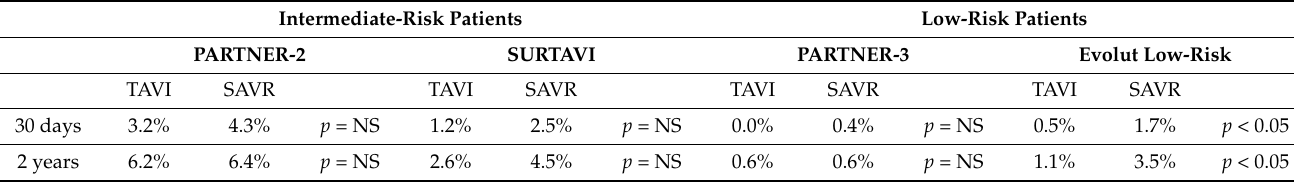
Table 2. Rates of disabling stroke in intermediate and low-risk